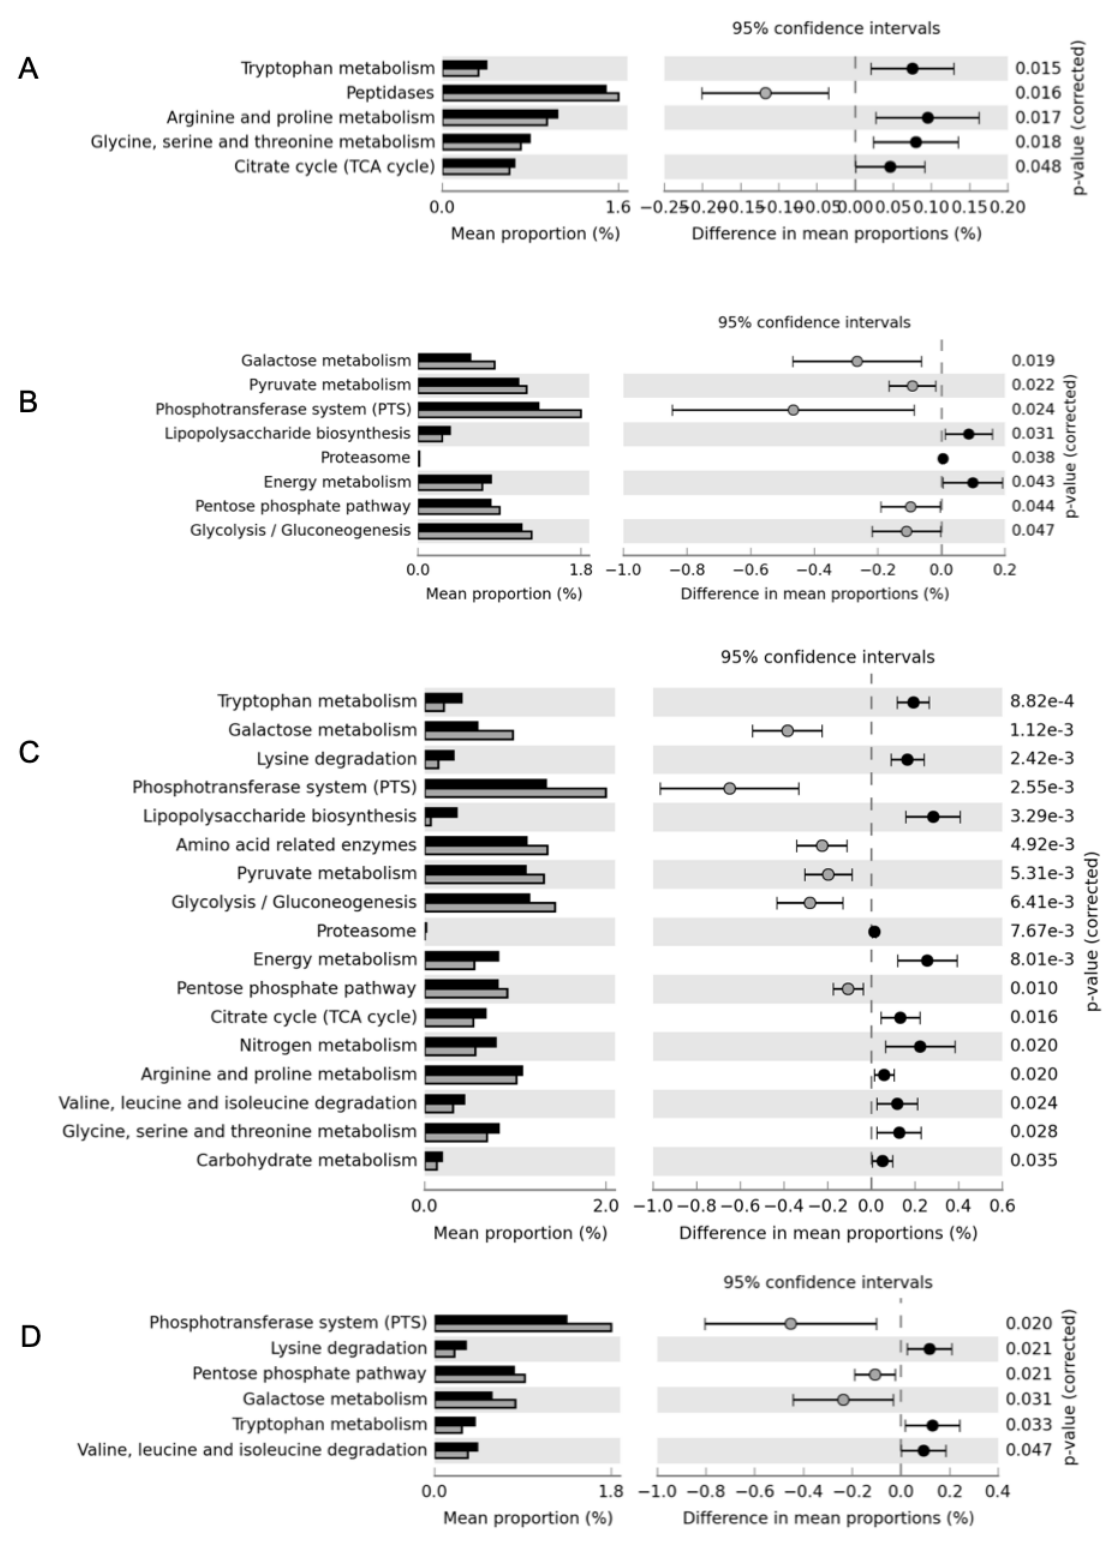
Figure 6. Extended error bar profile in predicted functional metagenomes of fresh cheese in presence of adjunct cultures (grey) Llb. sakei LSK04 ( A ), Lcb. rhamnosus RH05 ( B ), C. maltaromaticum CNB06 ( C ), and mix of adjunct cultures ( D ) in comparison with the standard production (black). Significant p -values are reported on the right.